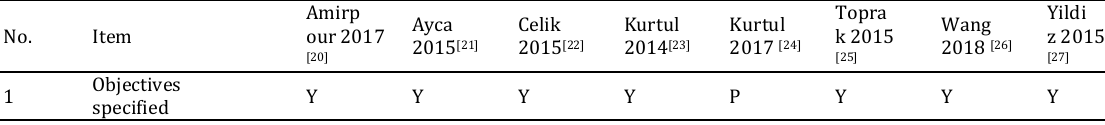
Table 2. Quality of the included studies.